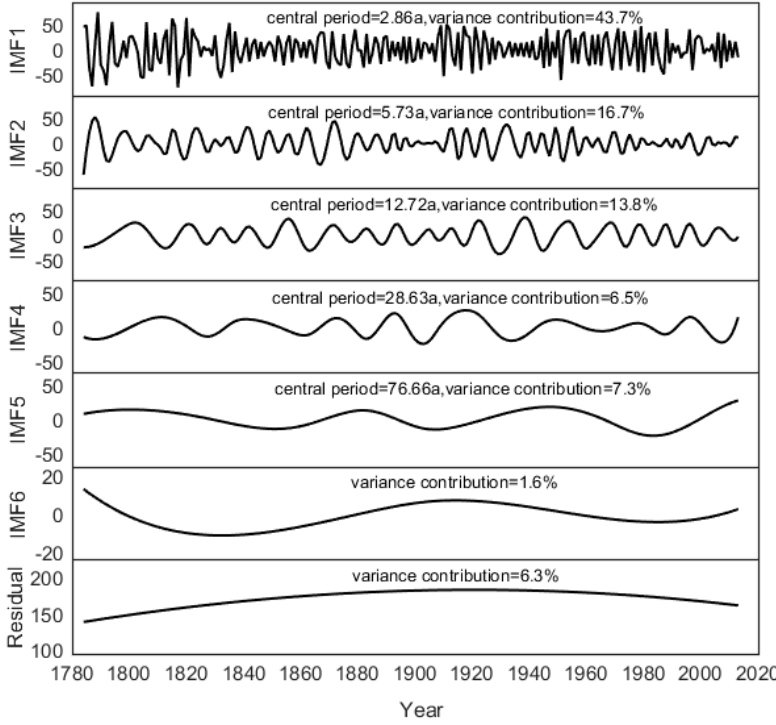
Figure 10. The ensemble empirical mode decomposition of the reconstruction precipitation.